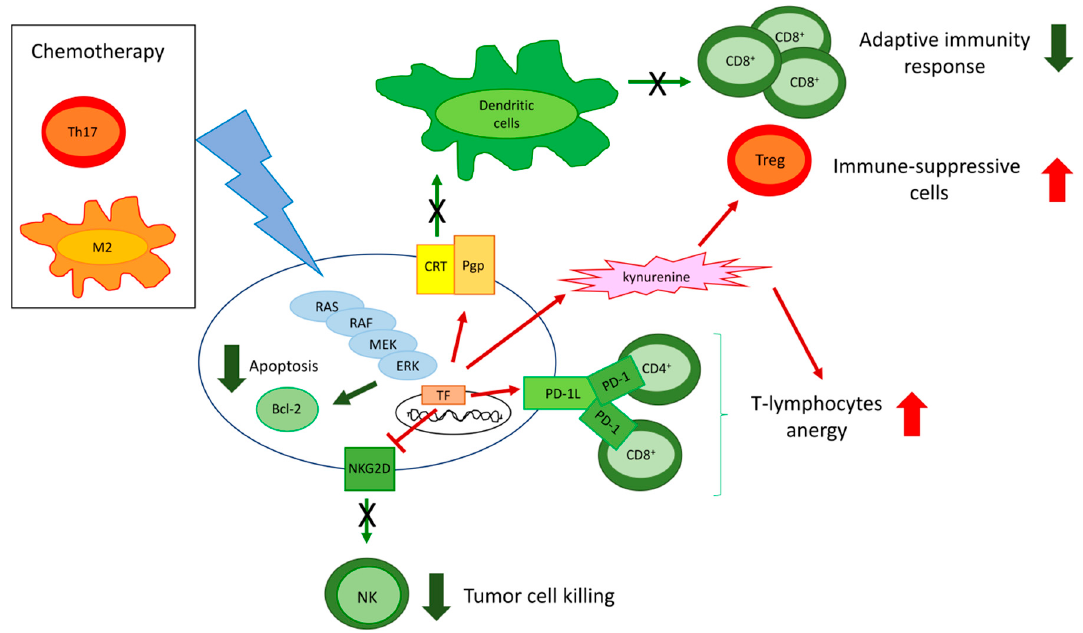
Figure 4. Cross-talks between tumor and immune cells determining chemo-immune-resistance. Chemotherapy and immune cells, e.g., T-helper 17 (Th17) cells producing IL-17 and M2-polarized